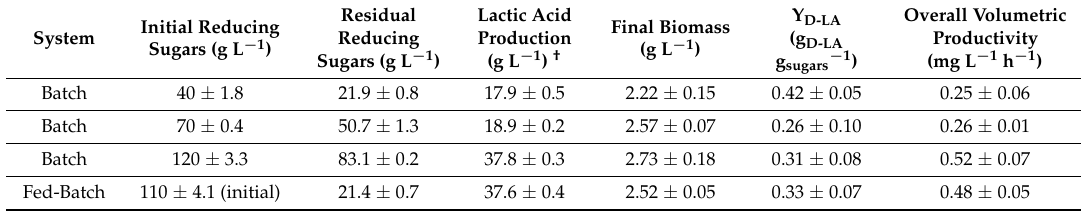
Table 1. Results of different fermentation processes, varying the initial reducing sugar concentration.